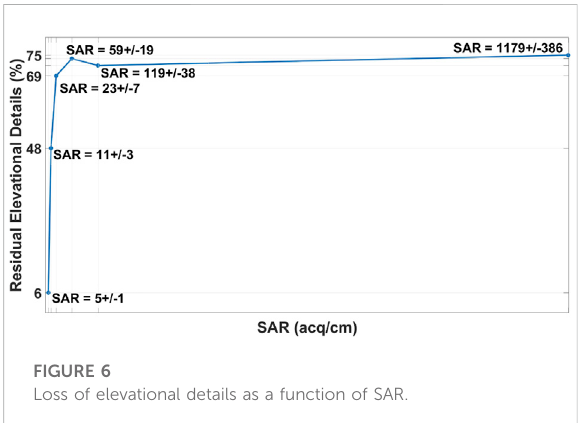
FIGURE 6 Loss of elevational details as a function of